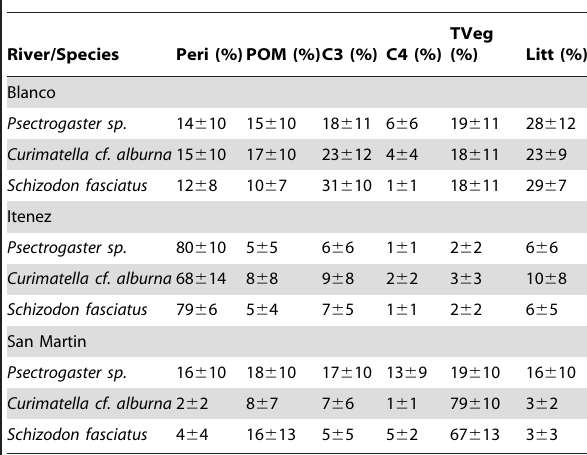
Table 3. Source relative contributions (mean % 6 sd, estimated by SIAR mixing model) to detritivore ( Psectrogaster sp. and Curimatella cf. alburna ) and herbivore ( Schizodon fasciatus ) fish diet in three rivers of the Ite´nez basin.